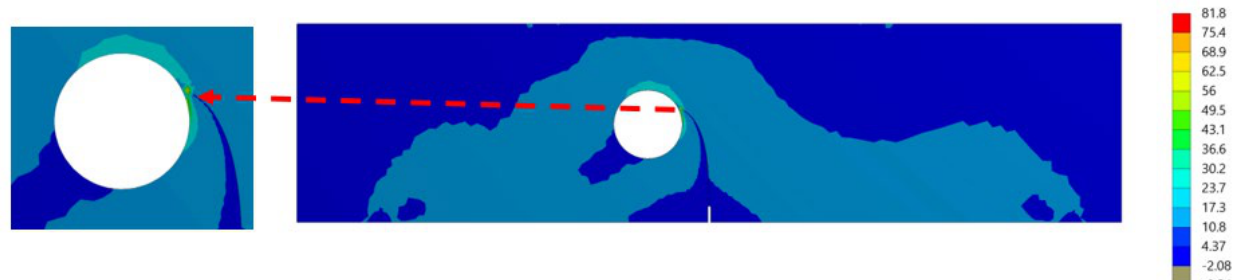
Figure 17. The distribution of the maximum principal stress (MPa) at the last step of the crack’s propagation.